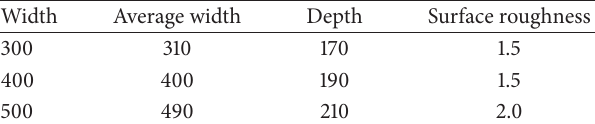
Table 3: The measurements of microchannels.